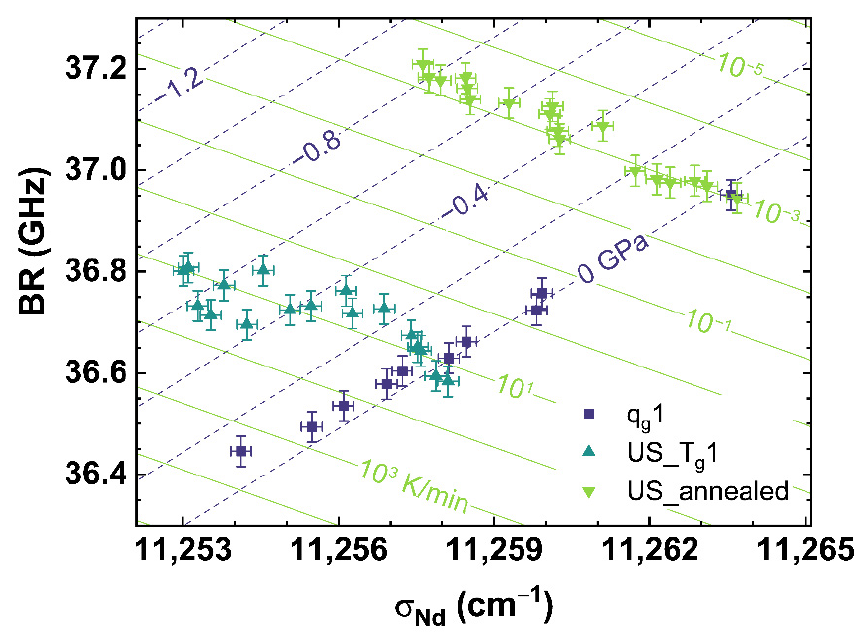
Figure 9. Observable comparison of BR over σ Nd for q g 1 (dark blue squares), US_T g 1 (cyan up triangles) and US_annealed (light green down triangles). The shown lines can be read as contour map based on the multiple linear regression models. The dark blue dashed lines indicate applied uniaxial stress, the light green lines indicate different cooling rates corresponding to the displayed values.